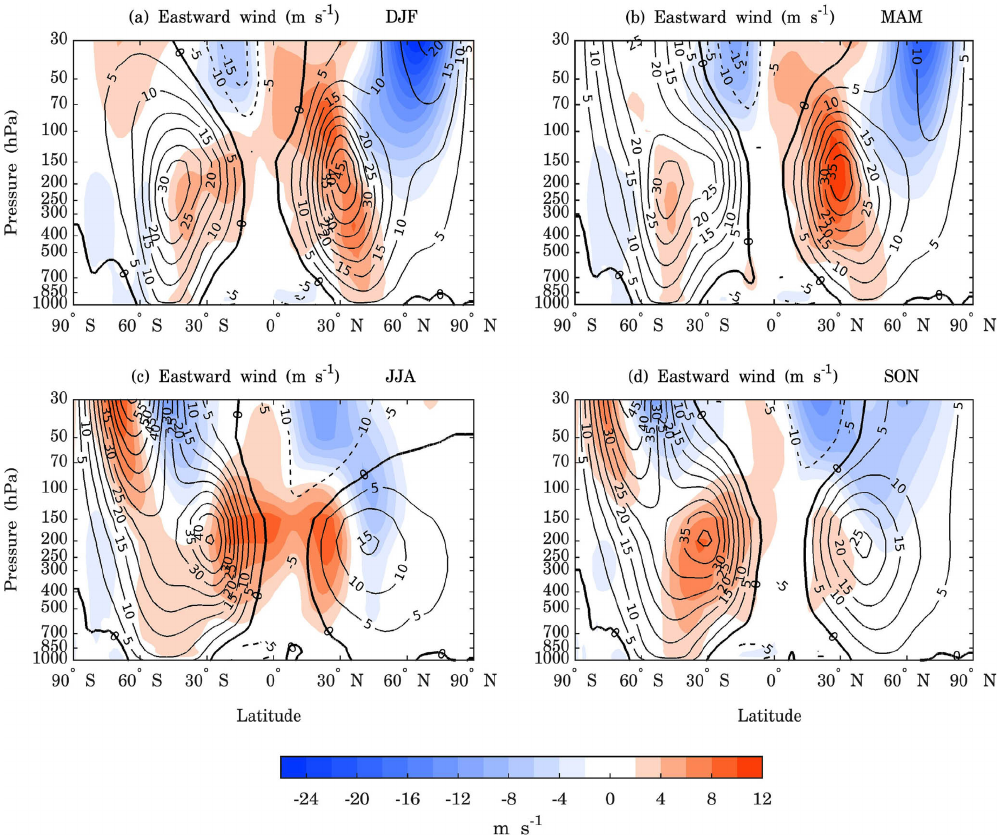
Figure 9. Contour lines showing the zonally averaged zonal wind for BESM-OA2.5 and the differences between the BESM-OA2.5 and 20CRv2 datasets are shaded. Both datasets were averaged over the period 1971–2000. The solid contour lines represent eastward zonal wind and the dashed contour lines represent westward zonal wind. The units are in meters per second and the contour interval is 5ms − 1 , with the zero-contour line